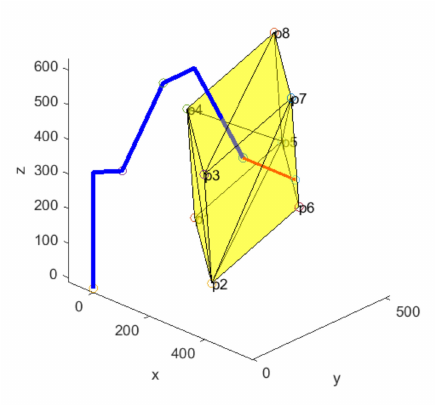
Figure 5. KDI computed for the articulated robot in point P (250, 300, 350) along any